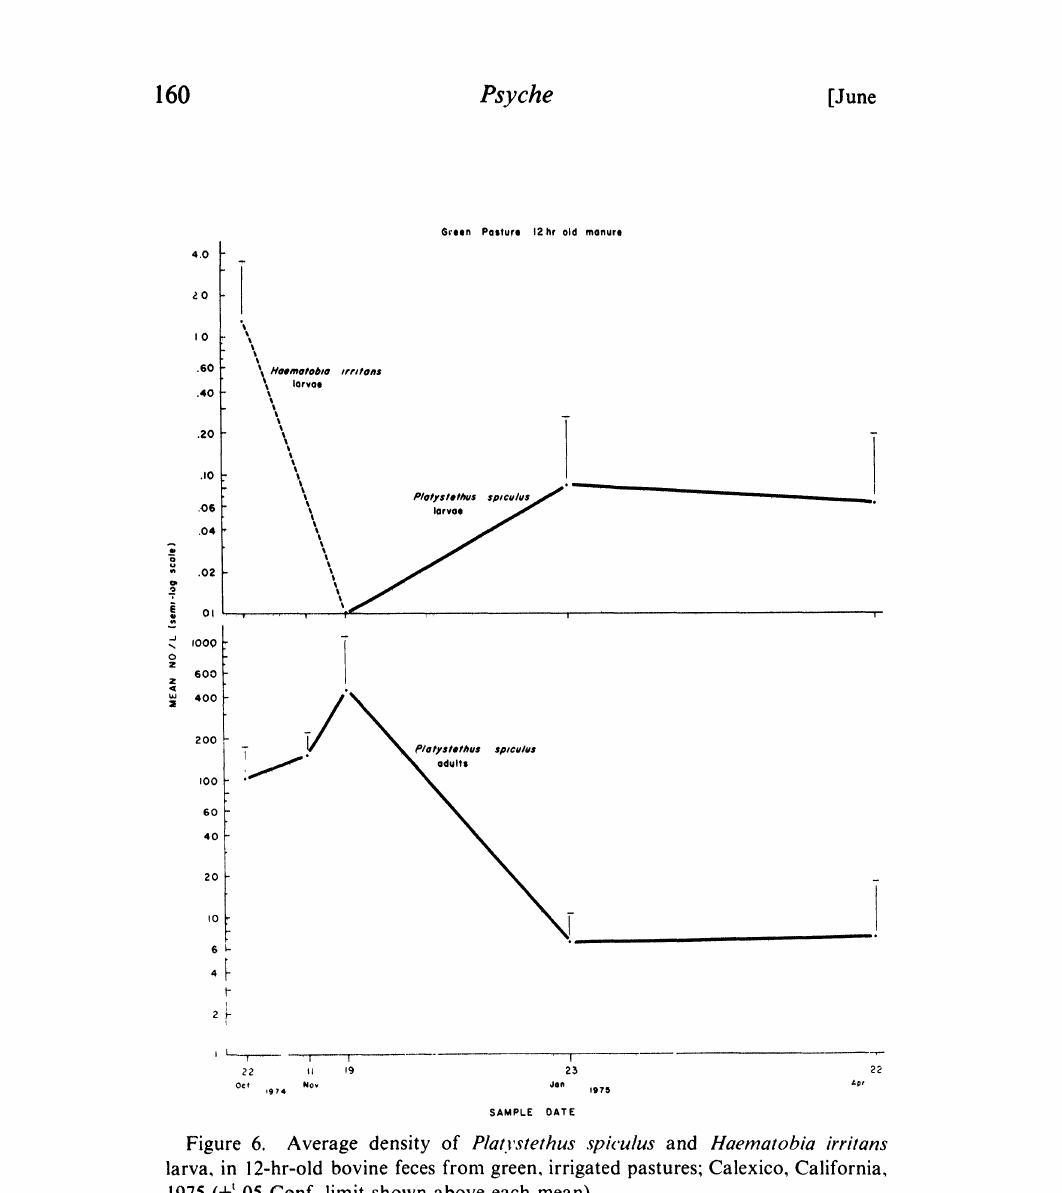
Figure 6. Average density of Platvstethus spiculus and Haematobia irritans larva, in 12-hr-old bovine feces from green, irrigated pastures; Calexico, California, 1975 (+’ 05 Conf, limit shown above each